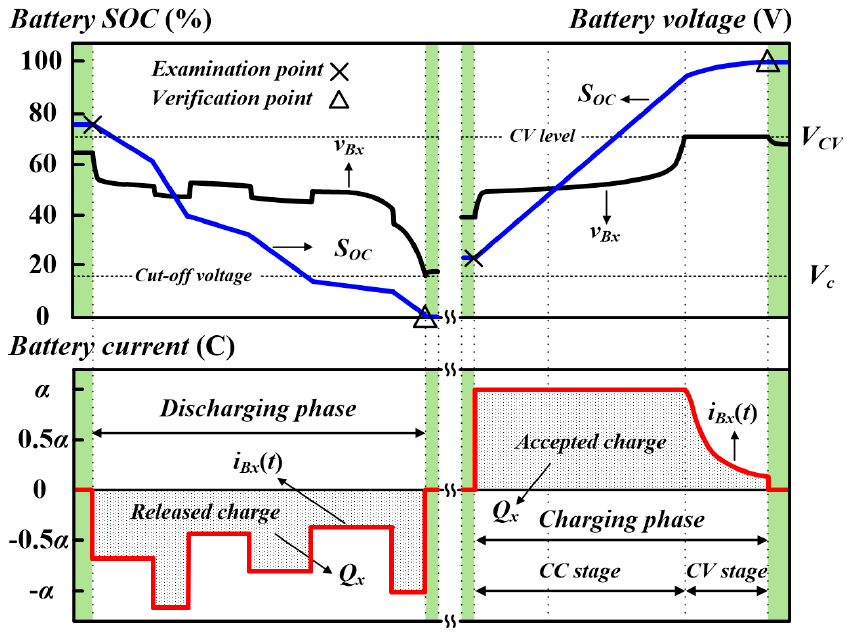
Figure 3. Partial calibration procedure.